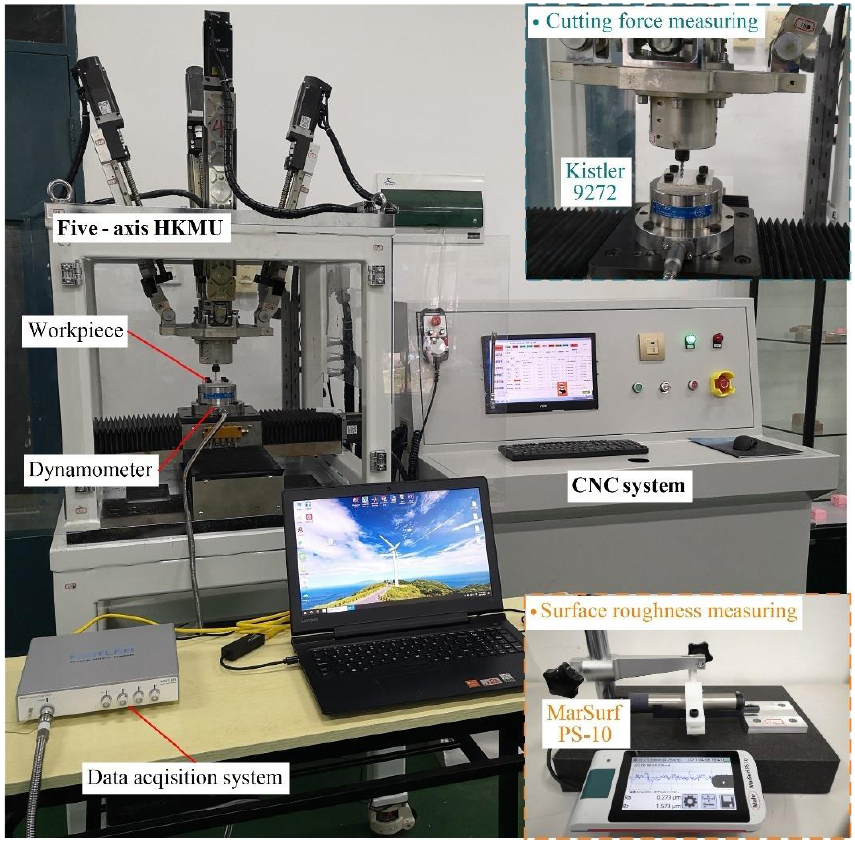
Figure 6. Experimental setup for cutting tests for the five-axis HKMU.